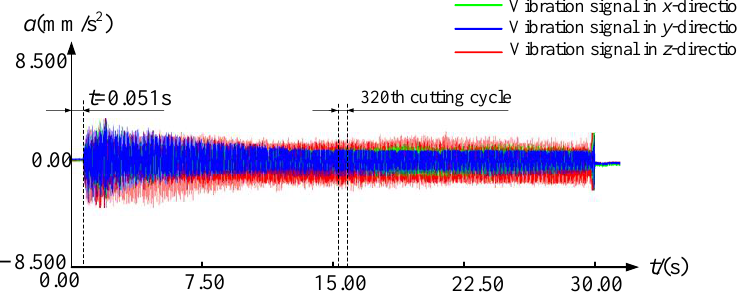
Figure 9. Experimental cutting vibration acceleration signals for scheme 2.